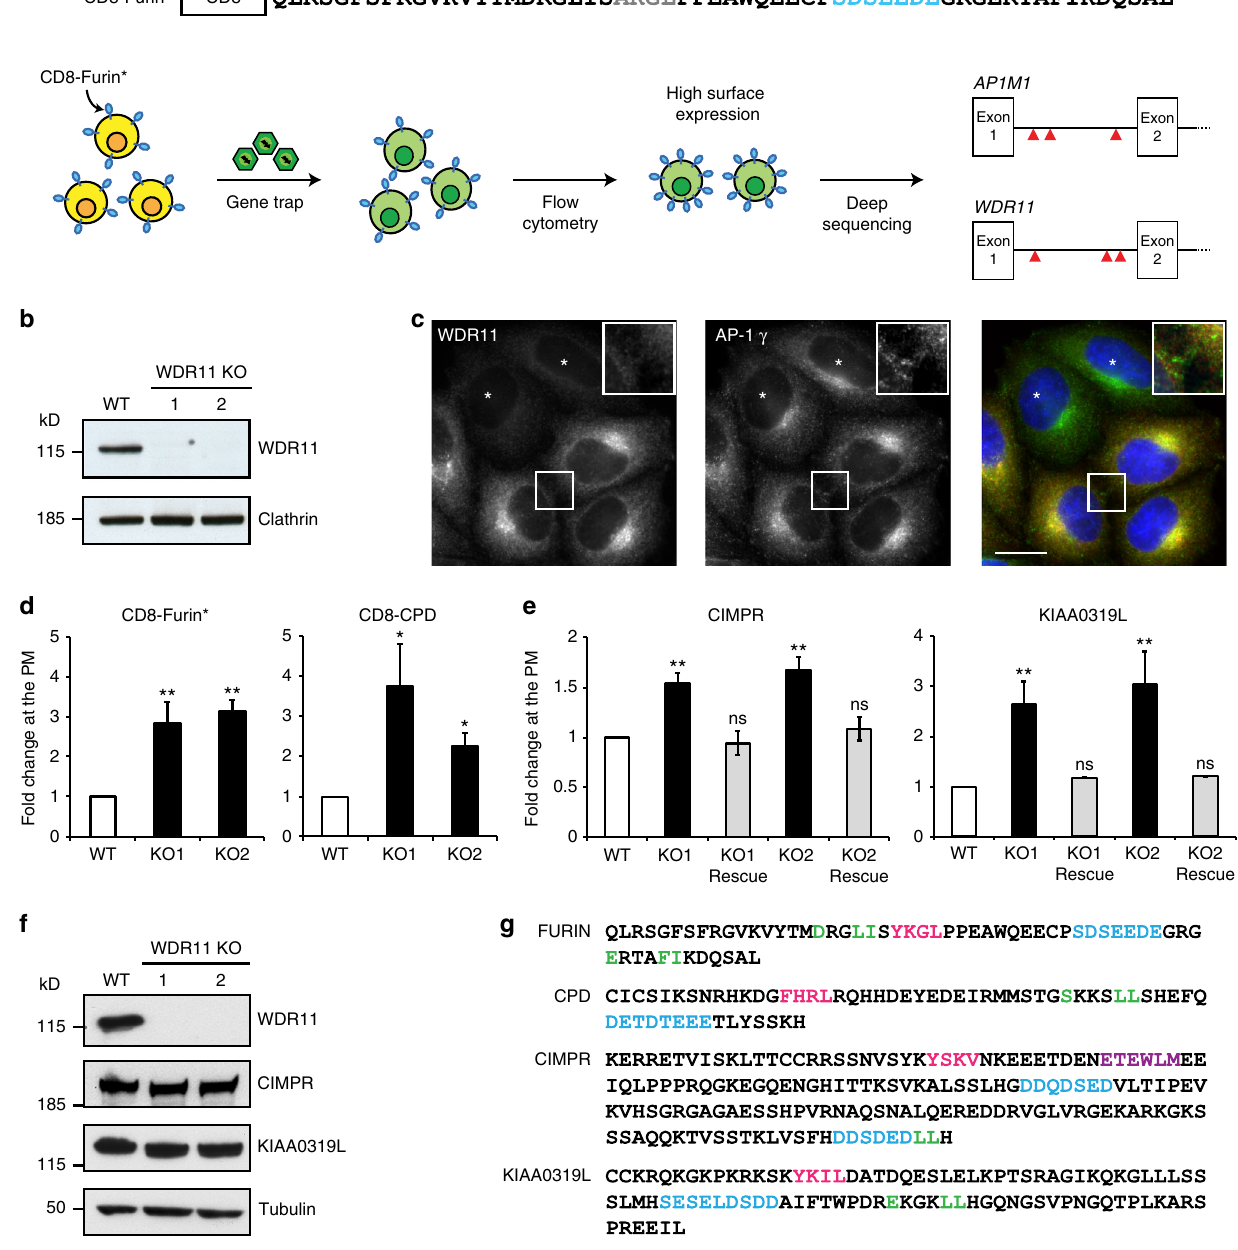
Fig. 1 Identi fi cation of WDR11 as a protein involved in acidic cluster sorting. a A CD8-Furin* chimera was constructed with a mutation in the YKGL sorting signal (AKGL). Blue: acidic cluster. Near-haploid KBM7 cells stably expressing this construct were infected with a gene-trap retrovirus. Mutant cells with increased surface expression of the construct were isolated by fl ow cytometry, DNA was extracted and viral insertions were identi fi ed by deep sequencing. Two hits were found, encoded by the AP1M1 and WDR11 genes. b The WDR11 gene was disrupted in HeLa cells and the knockout was con fi rmed by western blotting, using clathrin heavy chain as a loading control. c A mixed population of wild-type and WDR11-knockout cells was double labelled for WDR11 and the AP-1 γ subunit. The insert shows that WDR11 (red) does not display the punctate peripheral labelling seen with anti- γ (green). Scale bar: 20 µ m. d Wild-type and WDR11-knockout cells were transfected with plasmids encoding CD8-Furin* or CD8-CPD, together with a GFP-encoding plasmid to control for transfection ef fi ciency. Flow cytometry showed that the knockout caused an increase in the surface expression of both constructs. e Surface levels of endogenous CIMPR and KIAA0319L were quanti fi ed in wild-type cells, WDR11-knockout cells and WDR11-knockout cells transfected with GFP-tagged WDR11. The knockout caused an increase in surface expression of both proteins, which could be rescued with tagged WDR11. In d and e error bars: S.E.M.; one-way ANOVA and Bonferroni post hoc test; ** P ≤ 0.01, * P ≤ 0.05, ns P > 0.05; n = three independent experiments. f Western blots of control and WDR11-knockdown cells, showing that the total amounts of endogenous CIMPR and KIAA0319L are unchanged. g Sequences of the cytoplasmic tails of the four proteins, with known or potential sorting signals indicated in colour colour (pink: YXX Φ ; green: dileucine; blue: acidic cluster; purple: retromer sorting